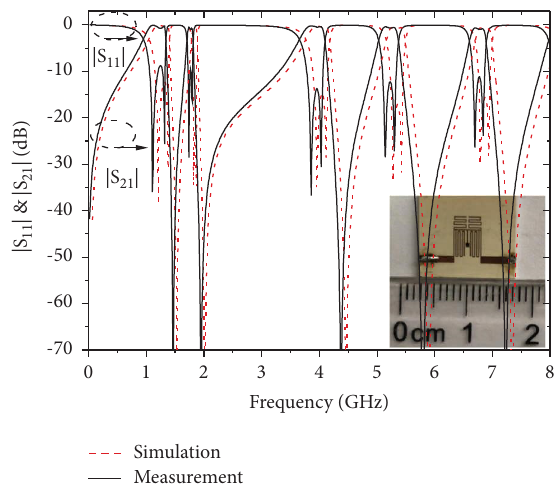
Figure 12: Simulated and measured results of quint-band BPF.